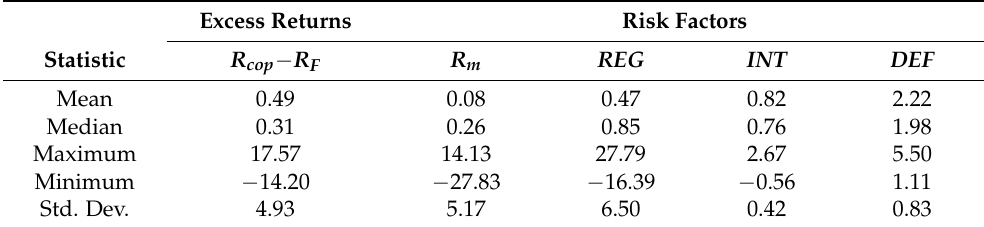
Table 3. Variable statistics.